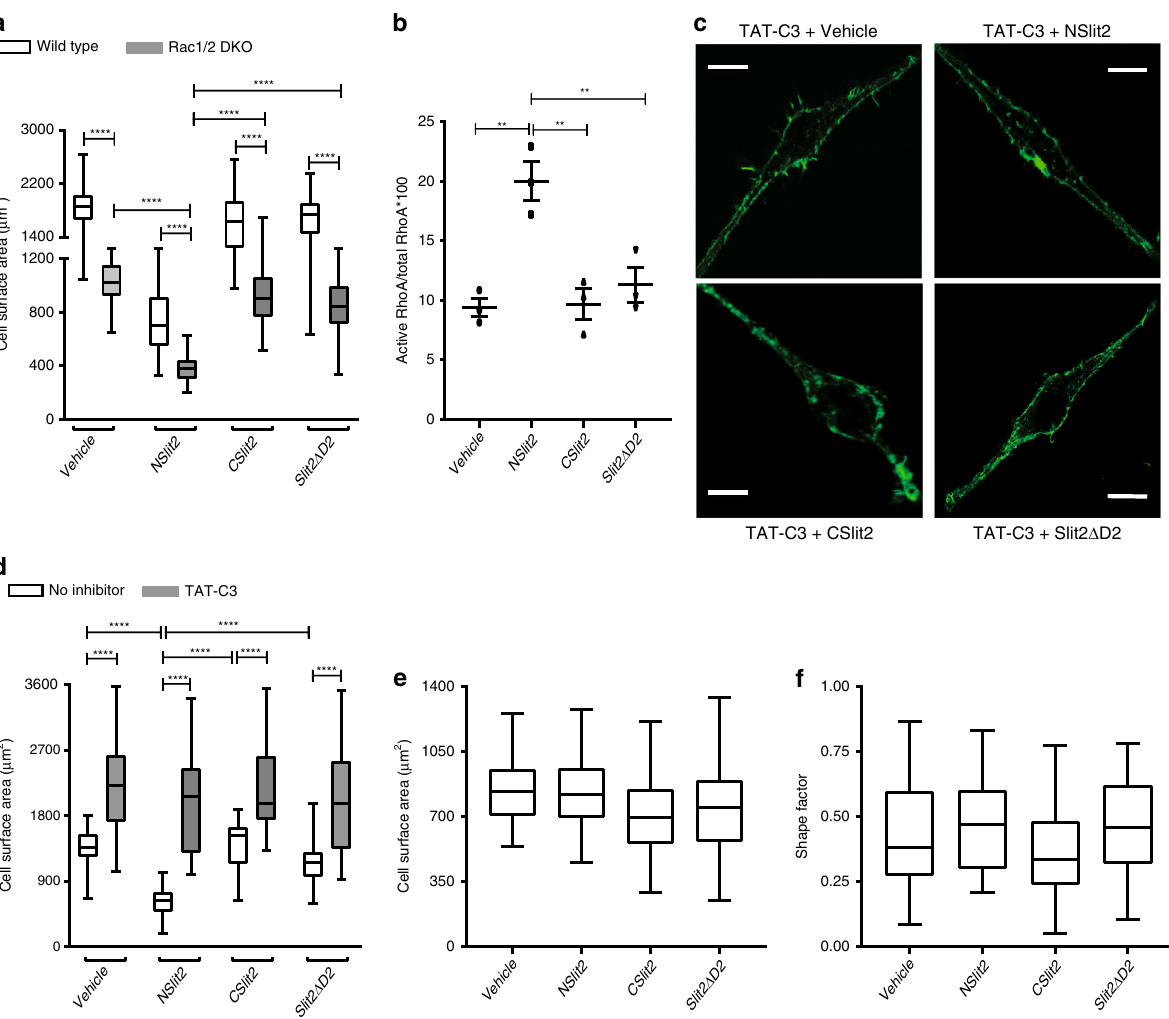
Fig. 2 NSlit2 activates RhoA and results in cytoskeletal rearrangement in macrophages. ( a , d , e , f ) Data are presented as boxplots where middle line is the median; lower and upper hinges correspond to the fi rst and third quartiles; whiskers represent minimum and maximum values. n = 50 cells per treatment group per experiment over three independent experiments. Comparisons between the groups were made by one-way ANOVA in ( b , e , f ) and two-way ANOVA in ( a , d ), followed by post hoc Tukey ’ s multiple comparison test. a Primary BMDM from wild-type (WT) or Rac1/2 double knockout (DKO) mice were cultured for 10 days, and cell spreading assays were performed as described in Fig. 1c. Cell surface area was measured as in Fig. 1d. **** p < 0.0001, WT vs DKO BMDM and p < 0.0001, NSlit2 vs vehicle, CSlit2, or Slit2 Δ D2. b RAW264.7 macrophages were incubated with vehicle, NSlit2, CSlit2 or Slit2 Δ D2 for 15min at 37°C and active and total RhoA levels were measured using a G-LISA assay. ** p = 0.0063, 0.0093, and 0.0053 for NSlit2 vs vehicle, CSlit2, Slit2 Δ D2, respectively. c RAW264.7 cells were incubated with the RhoA/B/C inhibitor, TAT-C3, for 4 h followed by vehicle, NSlit2, CSlit2, or Slit2 Δ D2 treatment for 15min and cell spreading was performed as described in Fig.1c. Scale bar, 20 μ m. d Surface area for cells in ( c ) was measured as in Fig. 1d. **** p < 0.0001, vehicle vs TAT-C3 and p = 0.8877, 0.9470, and 0.9952 for NSlit2 vs vehicle, CSlit2, Slit2 Δ D2 in TAT-C3-treated conditions, respectively. e , f Experiments were performed as in Fig. 1c but cells were fi rst incubated with a formin inhibitor, SMIFH2, for 30 min. e Cell surface area was measured as in Fig. 1d. p = 0.9220, 0.8356, and 0.7215 for NSlit2 vs vehicle, CSlit2, Slit2 Δ D2, respectively. f Shape factor was measured as in Fig. 1e. p = 0.7557, 0.6594, and 0.9950 for NSlit2 vs vehicle, CSlit2, Slit2 Δ D2 respectively. Source data for ( a , b , d , e , f ) are provided as a Source Data fi effects of modulating RhoA signaling on macropinocytosis. Inhi- signi fi cantly enhanced (Supplementary Fig. 4a, b). RhoA knock- bition of RhoA/B/C, using TAT-C3, induced a twofold increase in down partially, but signi fi cantly, restored macropinocytosis after constitutive macropinocytosis by RAW264.7 macrophages (Fig. 4a, exposure to NSlit2 (Supplementary Fig. 4a, b). To explain this b). Conversely, activation of RhoA/B/C using Rho Activator II result, we investigated the speci fi c effect of NSlit2-induced Rho signi fi cantly decreased average number of macropinosomes per cell activation on its inhibition of Rac activity 43 . As expected, phar- macological inhibition of Rho activity with TAT-C3 resulted in an (Fig. 4a, b). There were also changes in the average macropinosome increase in total active Rac levels in macrophages, as measured by size with TAT-C3 and Rho Activator II treatments (Fig. 4c). Next, Rac1/2/3 G-LISA (Supplementary Fig. 4c). NSlit2 treatment, fol- we examined the effect of NSlit2 on constitutive macropinocytosis. lowing TAT-C3, further reduced the Rac activity (Supplementary Exposure to NSlit2 signi fi cantly reduced the average number of Fig. 4c). These fi ndings suggest that NSlit2 inhibits macro- macropinosomes per cell (Fig. 4d, e) but did not produce a statis- pinocytosis in vitro by activation of RhoA, as well as through tically signi fi cant change in the macropinosome size (Fig. 4f). In inactivation of Rac1, possibly via SRGAP2, a Rac1-speci fi c slit-robo RhoA-de fi cient macrophages, constitutive macropinocytosis was